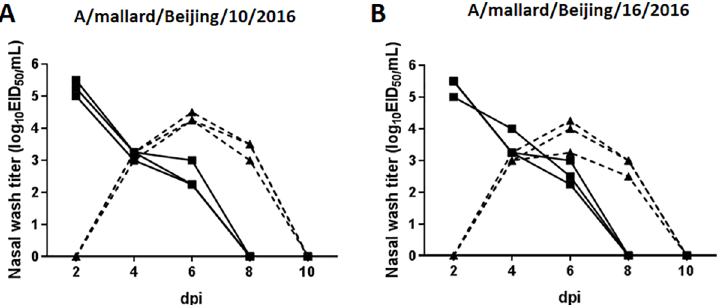
Fig 7. Contact transmission of H4N6 AIVs in guinea pigs. Three guineapigs were intranasallyinoculated with 10 6 EID 50 of A/mallard/Beijing/10/2016 (A) or A/mallard/Beijing/16/2016 (B) viruses. At 24 hpi, the inoculated guineapigs were placed in a cage with three naive guineapigs. Nasal wash titers are plotted as a function of time post-inoculation. Titers of intranasally inoculated animalsare represented by solid lines and filled squares; titers of exposedguineapigs are shown with dashed lines and filled